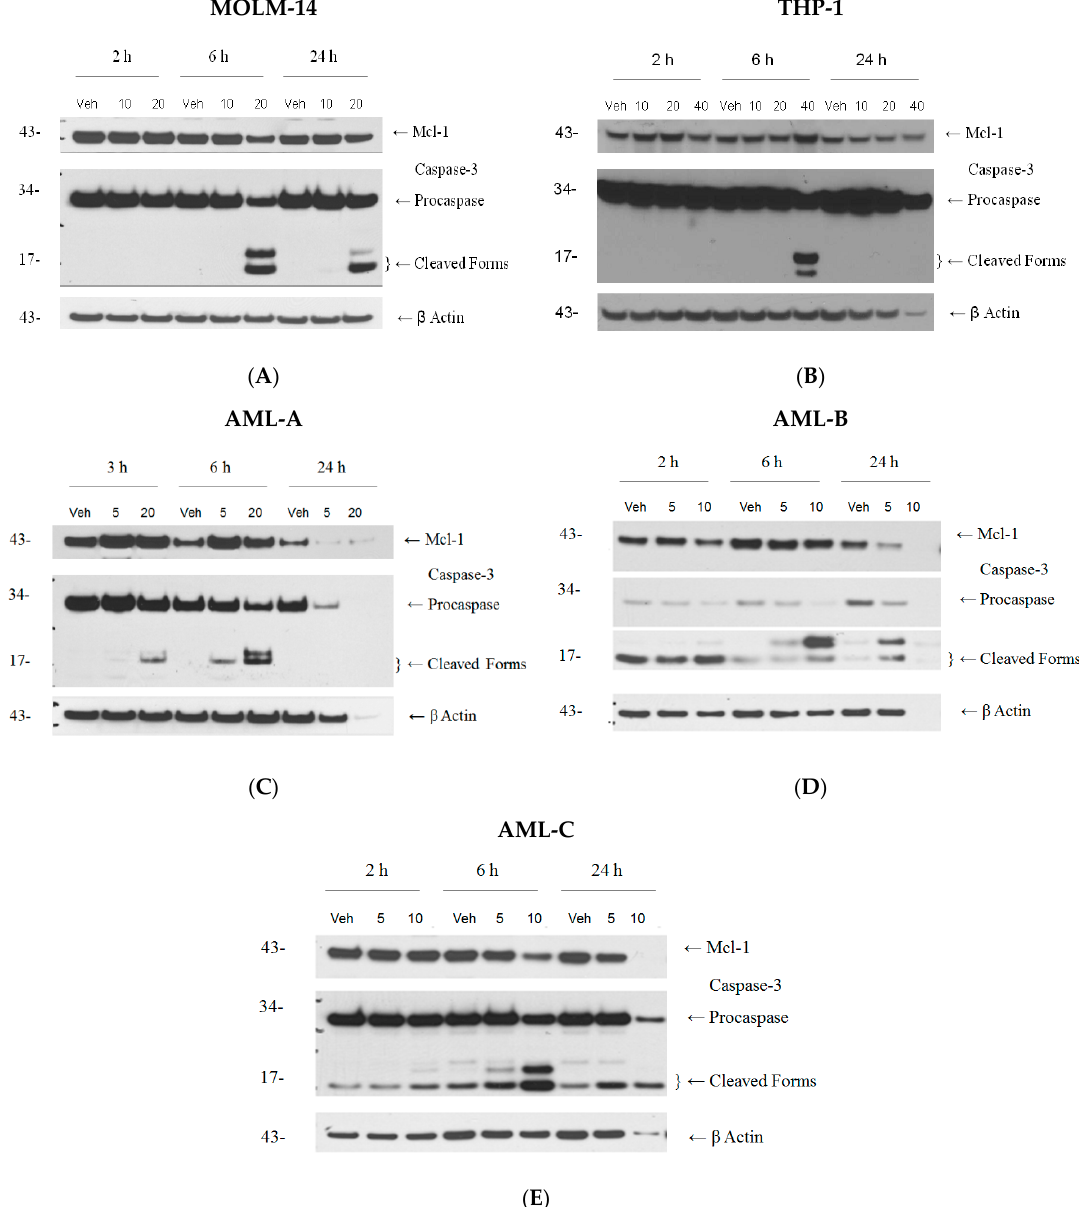
Figure 2. BiQ-1 induced apoptosis of AML cells as measured by Western Blot. ( A ) BiQ-1 treatment of MOLM-14 cells resulted in reduced Mcl-1 expression at 6 and 24 h post-treatment. ( B ) In contrast, at 6 and 24 h post-treatment in THP-1, a concentration-dependent increase in Mcl-1 expression was observed. ( A , B ) In MOLM-14 and THP-1, caspase-3 cleavage was observed after 6 h of treatment with 20 µM and 40 µM BiQ-1, respectively. Caspase-3 cleavage was maintained at 24 h in MOLM-14, but not THP-1. ( C , D , E ) In concentrations ranging from 10 µM to 20 µM, BiQ-1 induced caspase-3 cleavage within 6 h in primary AML cells from patients.